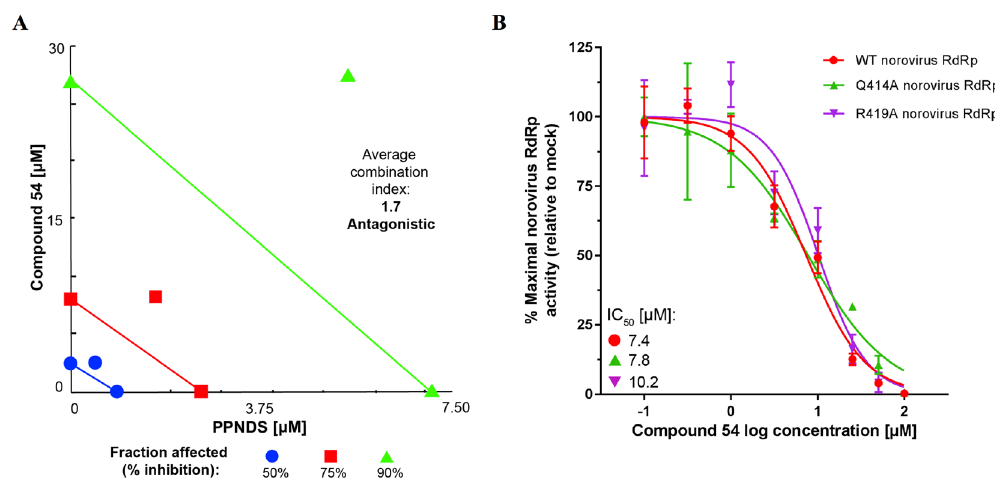
Figure 13. Compound 54 demonstrates competitive binding for the Site-B pocket with PPNDS, but displays unique amino acid interactions. ( A ) Isobologram of 54 (0.1–100 µ M) and PPNDS (0.025–10 µ M) examined in a 4:1 ratio respectively in combination. Together both molecules demonstrate antagonism against human norovirus Sydney 2012 RdRp activity with an average combination index of 1.7 over 50%, 75% and 90% inhibition. ( B ) Relative inhibitory effects of 54 on wild-type norovirus Sydney 2012 RdRp activity (red), mutants Q414 A (green) and R419A (purple), compared to mock treated samples (vehicle only). The IC 50 values are shown on the graph. The mean values of triplicate datasets are shown from three independent experiments with standard